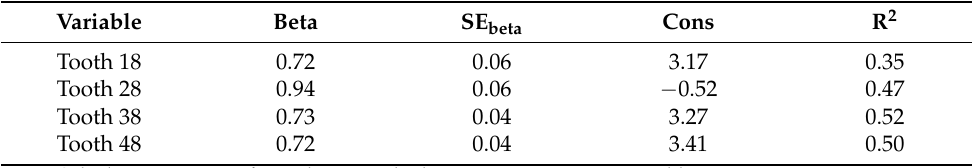
Table 2. Linear prediction of age when utilizing mineralization of each tooth individually. Variable